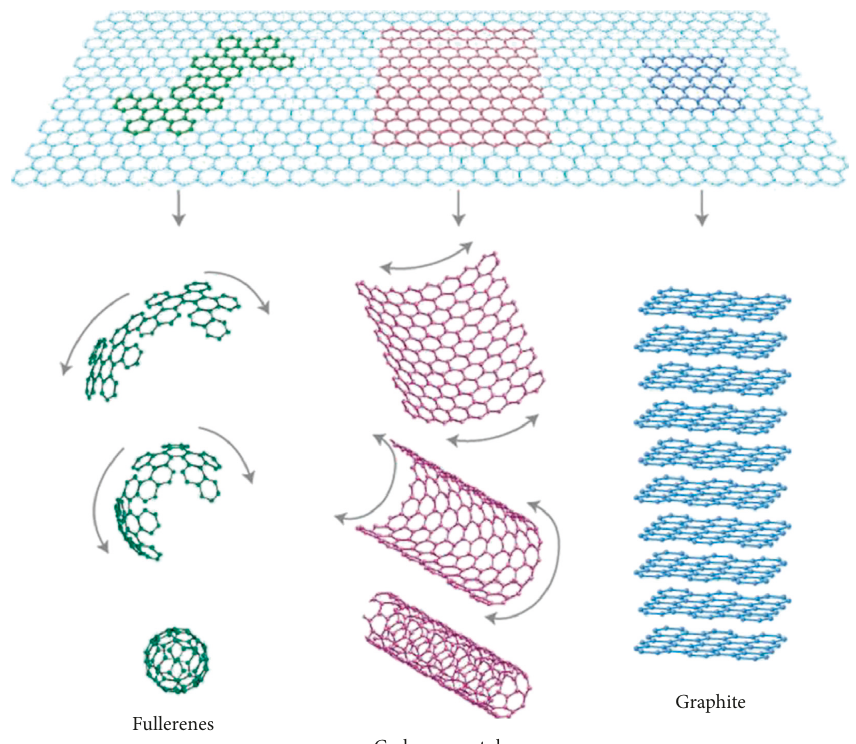
Figure 5: Graphene, the building block of all graphitic forms (taken from [13]).